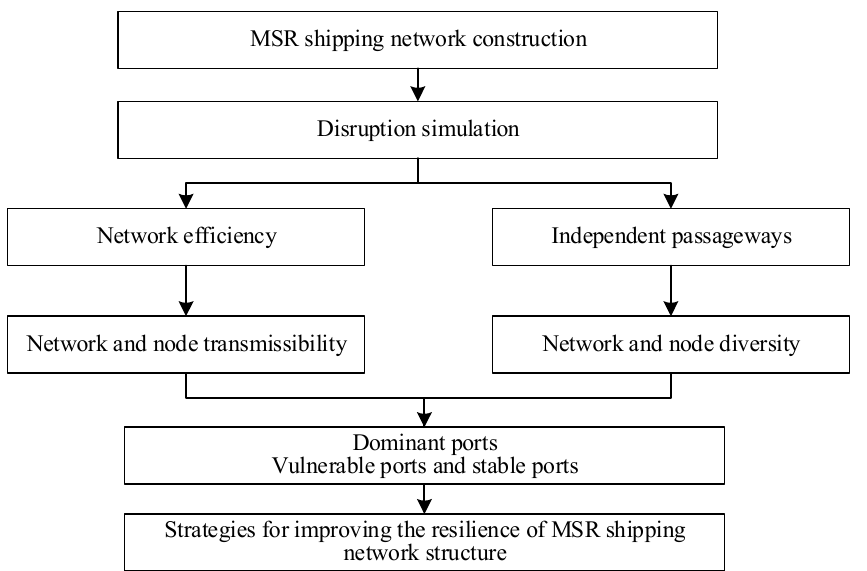
Figure 1. Research framework of this study.